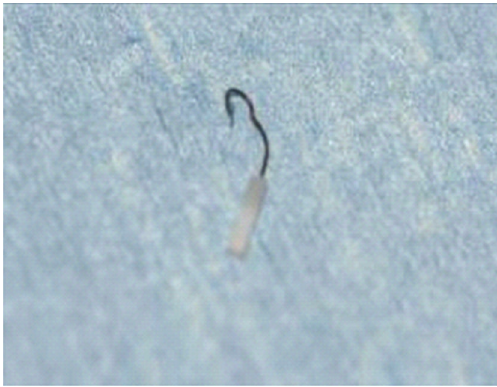
Figure 3: “Uncrimped” SMart